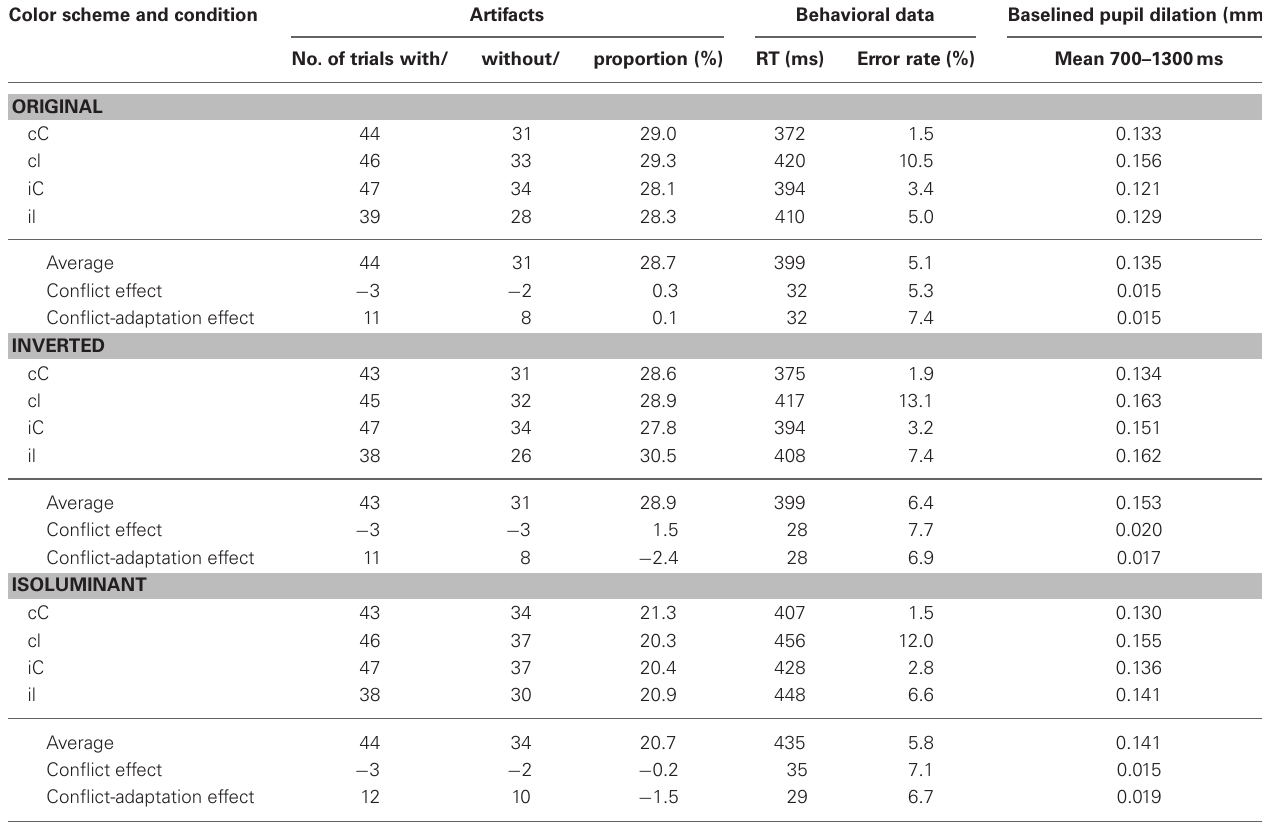
Note: Table displays averages across participants. Conflict effect, (([iI] + [cI]) − ([iC] + [cC]))/2; conflict-adaptation effect, ([cI] − [cC]) − ([iI] − [iC]); proportion artifacts, (No. of trials with artifacts – No. trials without artifacts)/No. of trials with artifacts. Behavioral and pupil dilation (relative to a 200ms prestimulus baseline) data are based on the trials without